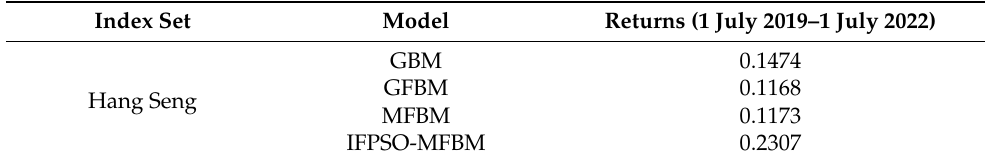
Table 9. Comparative analysis of Hang Seng index returns under four